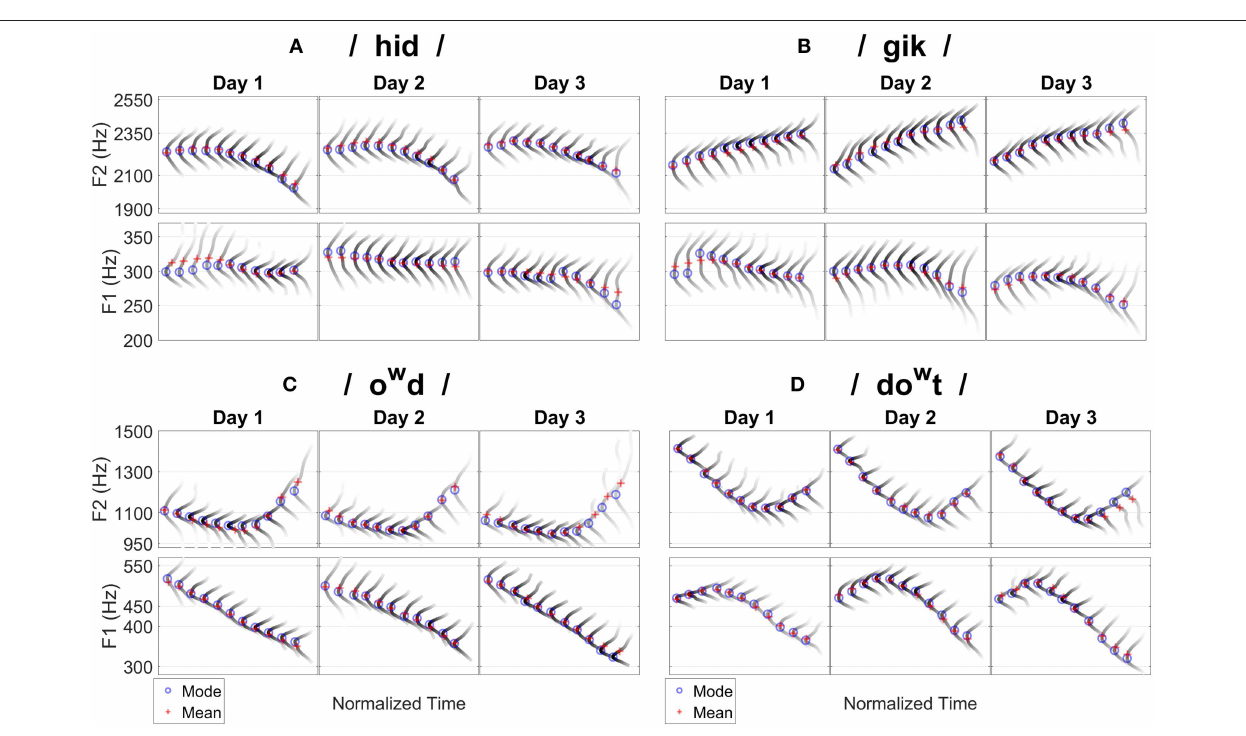
FIGURE 4 | Probability distributions of F1 and F2 measured at all the time points for the four words separately for each day. Each gray-scaled contour represents the probability density function estimated at one time point; darker color indicates higher probability. Red crosses track the means of distributions and blue circles track the modes (peak). Difference between mean and mode indicates the direction of skewness. (A) /hid/. (B) /gik/. (C) /owd/. (D)